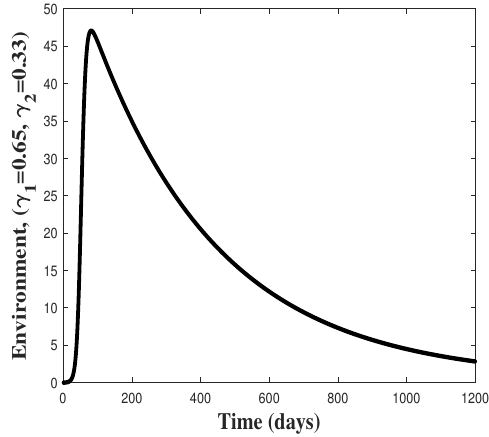
Fig. 3: Time course for the environment